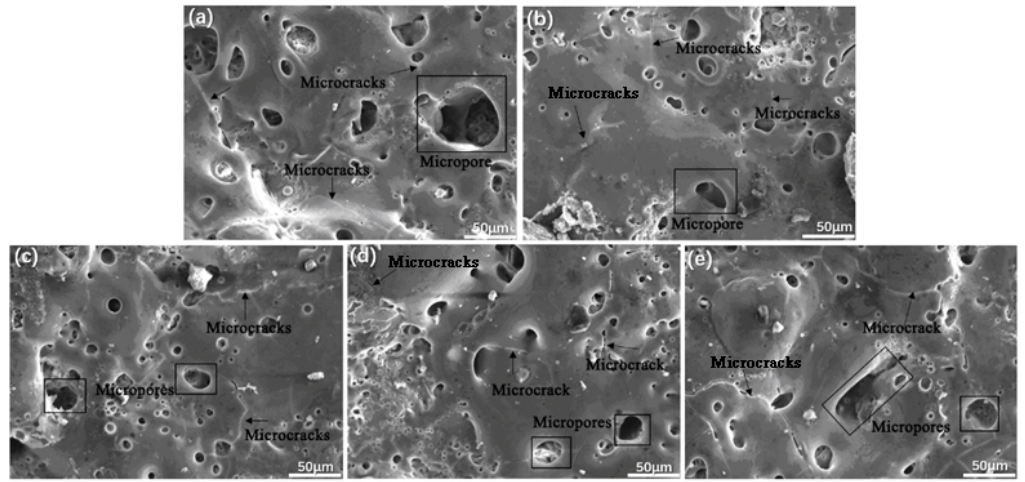
Figure 3. Surface morphology of MAO coatings ( a ) S0; ( b ) S1; ( c ) S2; ( d ) S3; ( e ) S4.